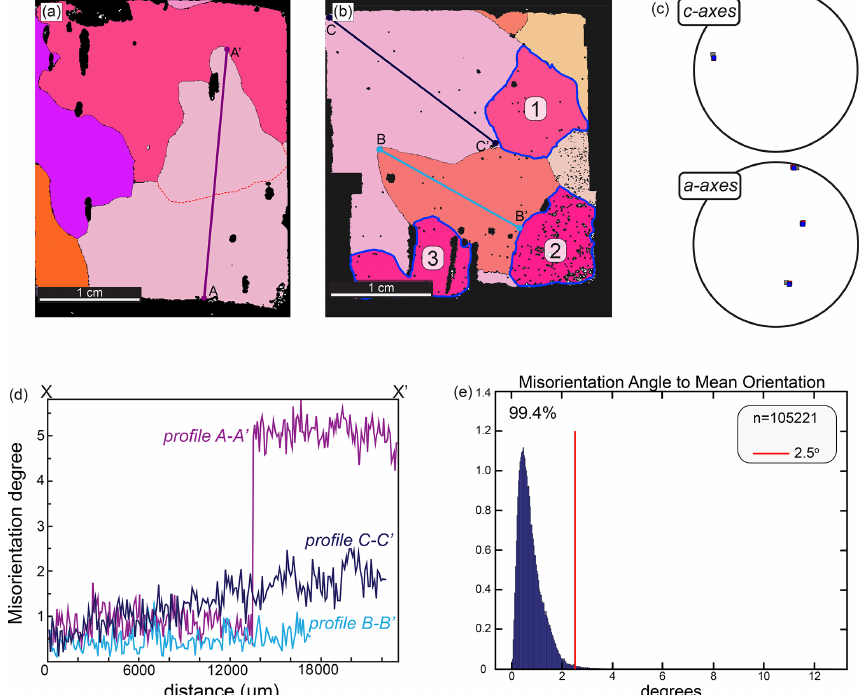
Figure 6. A typical whole section EBSD analysis with (a, b) maps of whole sections from SG28. (a) Subgrain boundary is shown with a dashed red line, and profile A–A (cid:48) crosses that boundary, (b) highlighting three potential island grains within the section and profile lines B–B (cid:48) and C–C (cid:48) across two grains; (c) one-point-per-grain c and a axes of the highlighted grains 1, 2 and 3 in (b) . (d) Misorientation profiles relative to the first pixel along A–A (cid:48) , B–B (cid:48) and C–C (cid:48) ; (e) misorientation angle of each pixel on EBSD map (b) with respect to the mean orientation of the grain. The red line highlights that 99.4% of the misorientations between pixels lie below 2.5 ◦